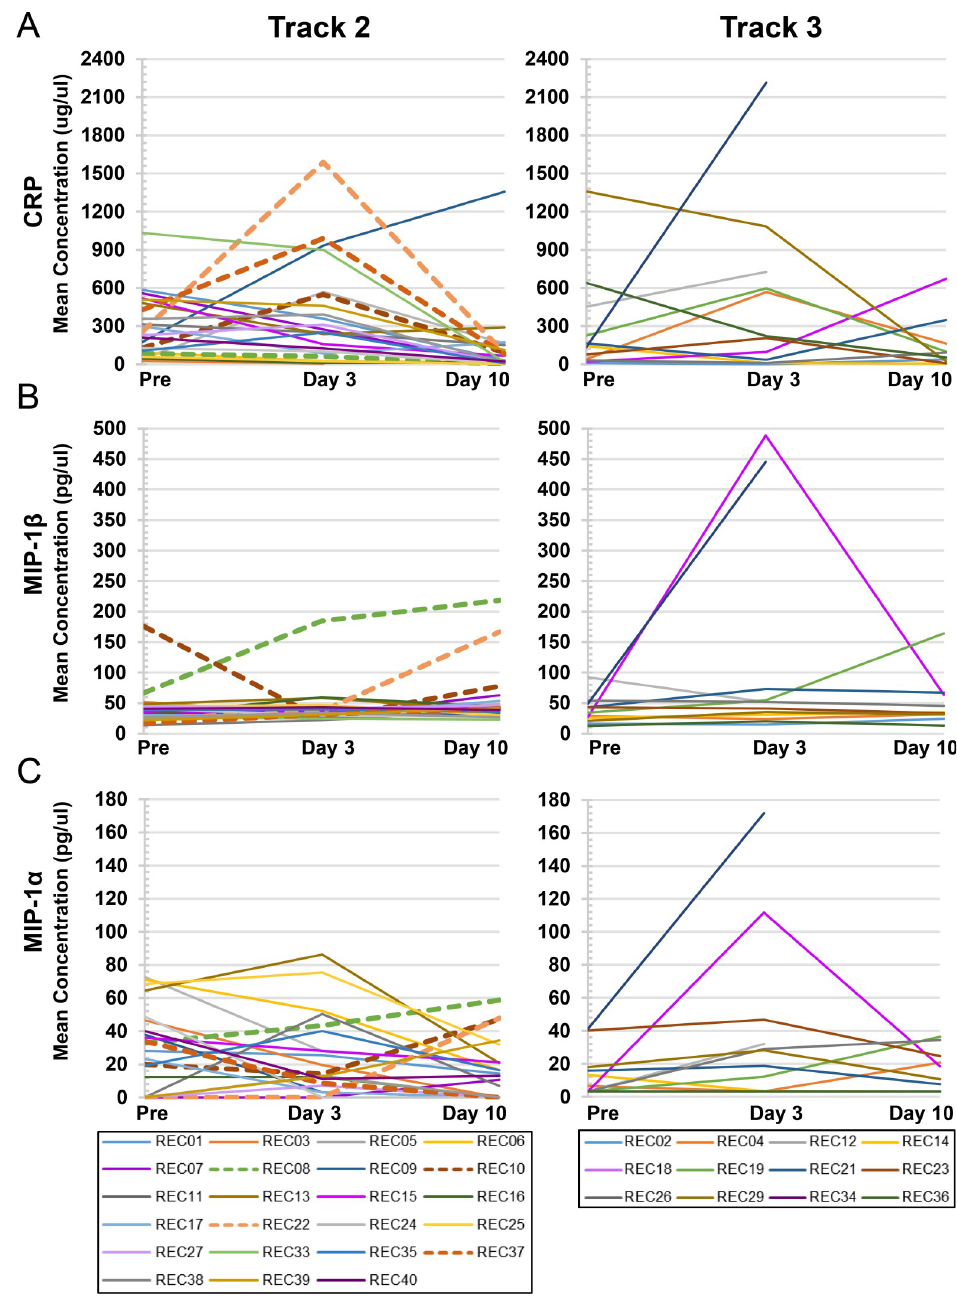
Fig 5. Individual concentration plots of cytokines/chemokines correlating with progression to intubation in Track 2 recipients. Statistical analyses, as detailed in Table 7, indicated that three analytes significantly correlated with the progression of COVID-19 respiratory disease in Track 2 recipients to the point of necessitating mechanical intubation (REC08, REC10, REC22, and REC37, indicated by dashed lines). Individual concentration plots are shown for recipients in Track 2 (left-hand panels; Pre-infusion, Day 3, n = 23; or Day 10, n = 22) and Track 3 (right-hand panels; Pre-infusion, Day 3, n = 12; or Day 10, n = 10), respectively for: (A) CRP; (B) MIP-1 β ; and (C) MIP-1 α . The change in the mean concentration of CRP from Pre-Infusion to Day 3 correlated with progression to intubation (p = 0.028); for MIP-1 β from Pre-Infusion to Day 3 (p = 0.049); and for MIP-1 α from Day 3 to Day 10 (p = 0.037).